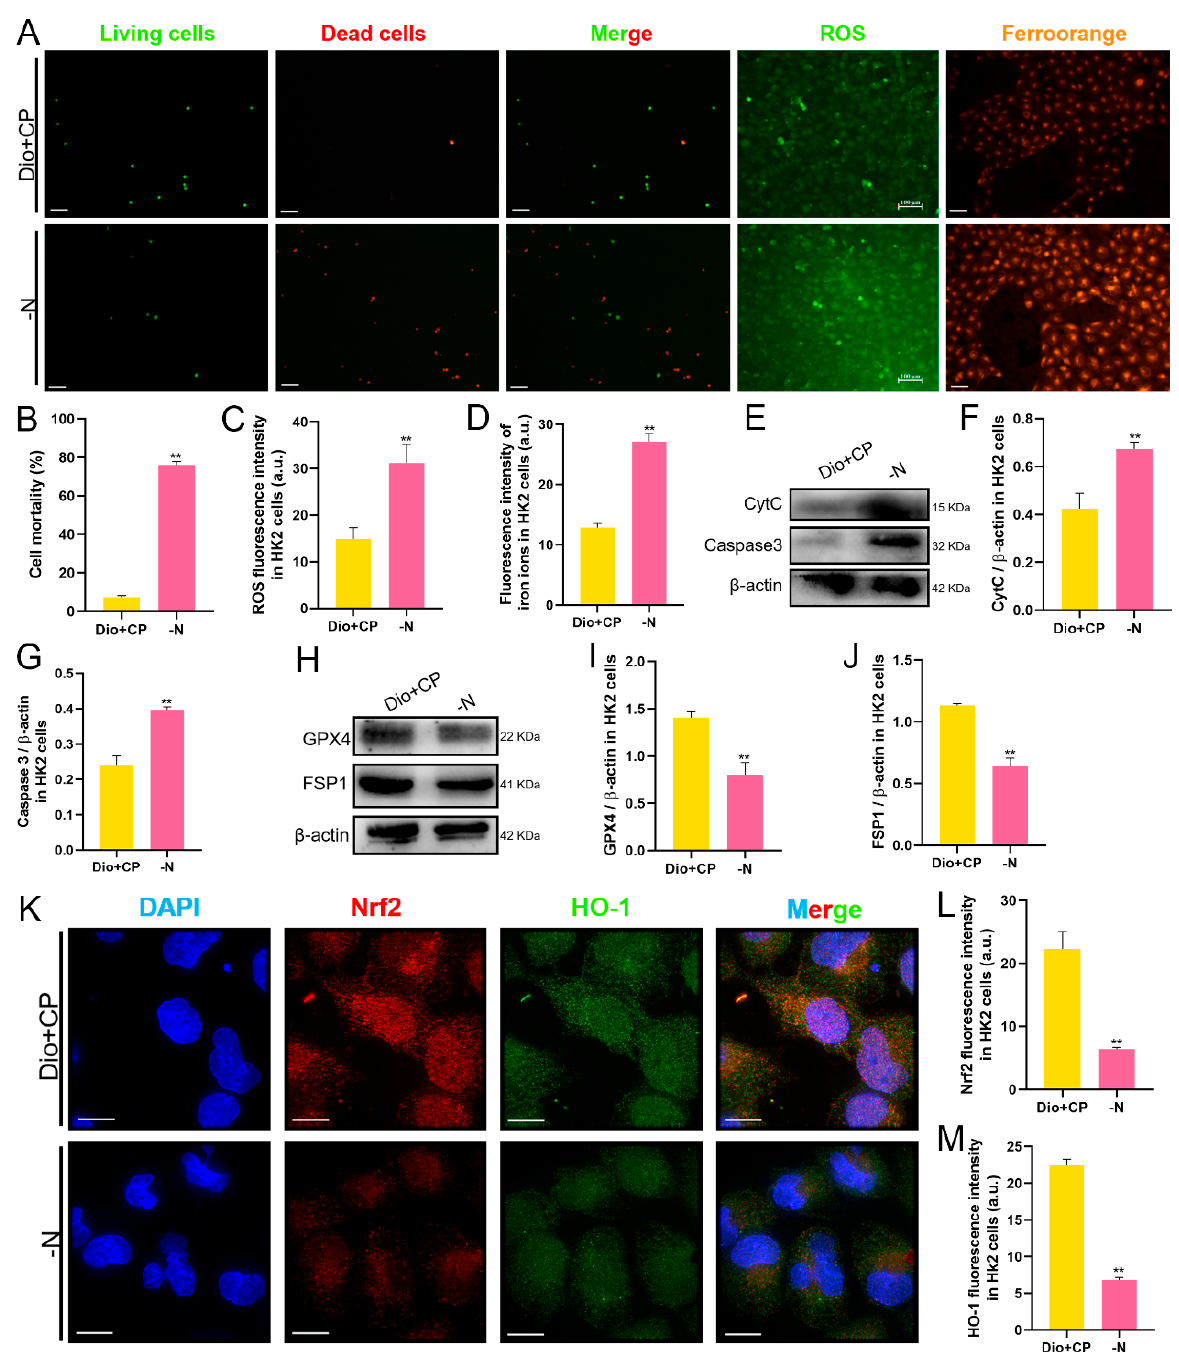
Figure 7. The protective effect of dioscin on HK2 cells is attenuated after Nrf2 inhibition. ( A – D ) Representative images and quantification of AO/EB staining (scale bar = 100 µ m), ROS staining (scale bar = 100 µ m) and ferro orange staining (scale bar = 50 µ m) in HK2 cells ( n = 5). ( E – G ) The protein expressions of CytC and Caspase3 in HK2 cells ( n = 3). ( H – J ) The protein expressions of GPX4 and FSP1 in HK2 cells ( n = 3). ( K – M ) Representative images and quantification of Nrf2 and HO-1 immunofluorescence (scale bar = 15 µ m) in HK2 cells ( n = 5). C, control group; Dio, dioscin